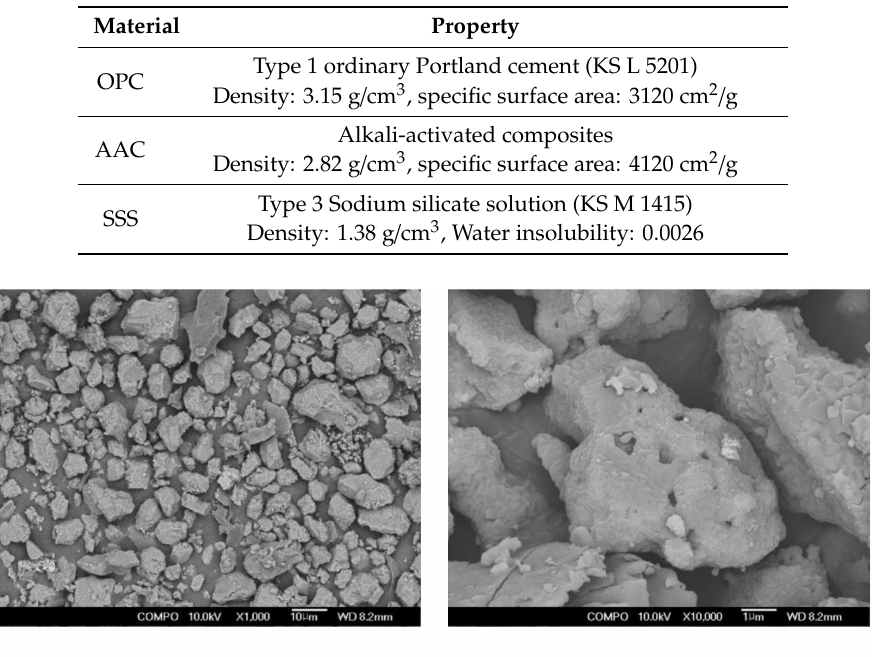
Table 2. Physical properties of the materials.